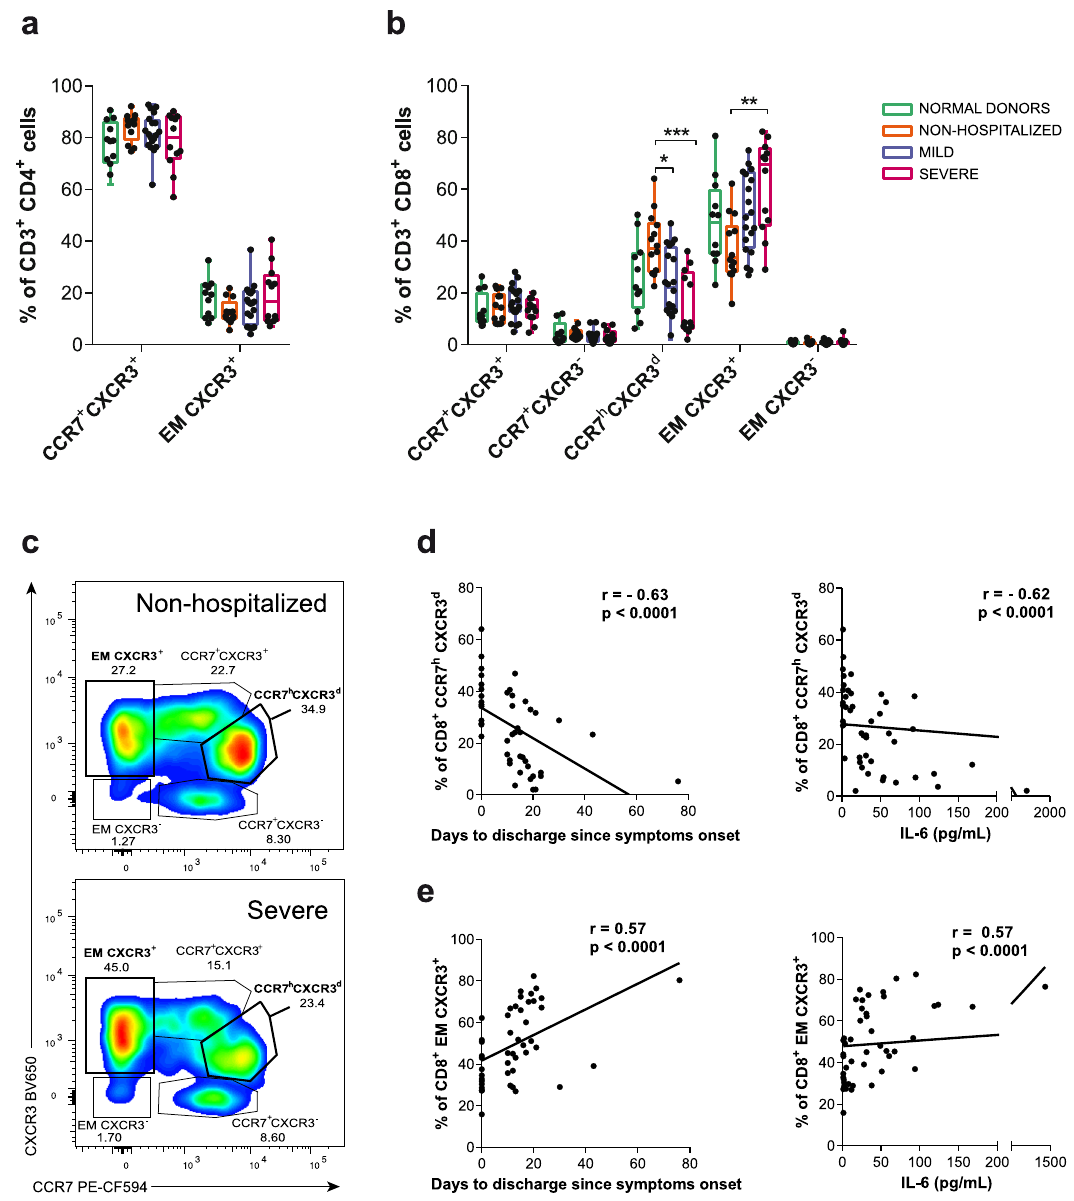
Fig. 2 T cell migratory patterns during acute SARS-CoV-2 infection. a , b The frequency of various T cell subsets de fi ned by CCR7 and CXCR3 within CD4 + ( a ) and CD8 + T cells ( b ). Each dot represents one patient of a speci fi c cohort, indicated by color code (normal donors n = 12; nonhospitalized n = 14; mild n = 20 and severe n = 12). Data are shown as individual patients and boxes and error bars represent median and interquartile range (IQR). Statistical comparisons were performed using Kruskal – Wallis rank-sum test with Dunn ’ s multiple comparison test (two-sided): CCR7 h CXCR3 d ( p = 0.029 and p = 0.0007) and EM CXCR3 + ( p = 0.002). c Representative fl ow cytometry plots gating the different CD8 + T cell subsets in a nonhospitalized (top) and a severe patient (bottom). d , e Correlations between days to discharge since symptoms onset or interleukin (IL)-6 baseline levels and the frequency of CD8 + CCR7 h CXCR3 d ( d ) and CD8 + EM CXCR3 + ( e ) subpopulations. Two-sided spearman rank correlation ( n =